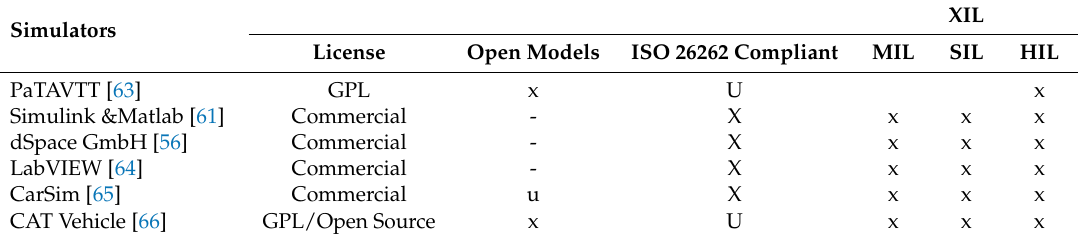
* Table Legend: x - Yes | u – Unknown or couldn’t be determined | - –